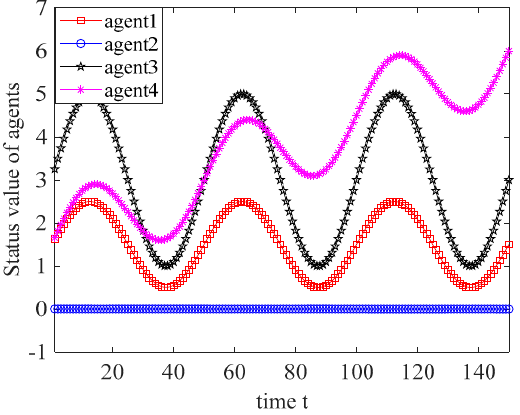
Figure 4. Multi-agent system trajectory at iteration 500.